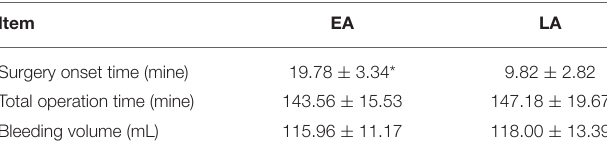
Dataarepresentasmean ± SD.ASA,AmericanSocietyofAnesthesiologists;EA,Epidural anesthesia; LA, Local anesthesia.